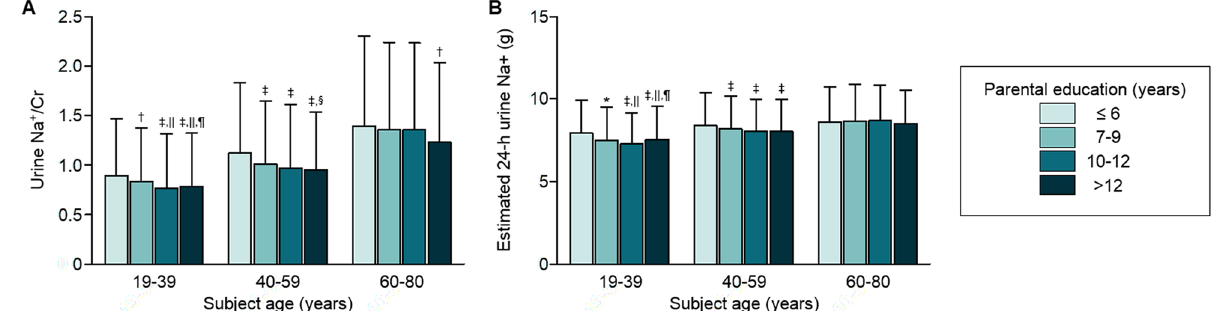
Figure 1. Comparison of urine sodium excretion by educational attainment and age. Error bars mean standard deviation. * P < 0.05, † P < 0.01, ‡ P < 0.001 vs. subjects with parental education year ≤ 6; § P < 0.05, || P < 0.001 vs. subjects with parental education year 7–9; ¶ P < 0.001 vs. subjects with parental education year 10–12 by one-Way ANOVA with Tukey’s multiple comparison